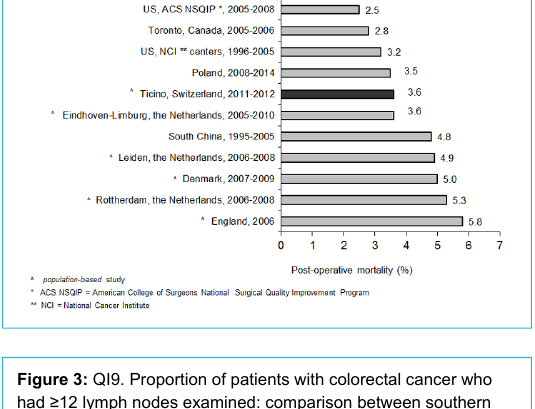
Figure 3: QI9. Proportion of patients with colorectal cancer who had ≥12 lymph nodes examined: comparison between southern Switzerland and other countries.